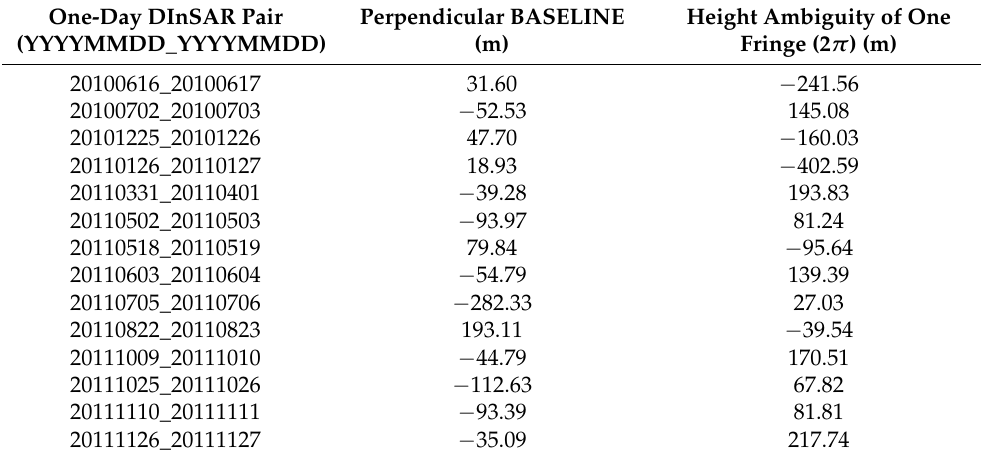
Table 1. List of COSMO-SkyMED one-day tandem DInSAR pairs used in this